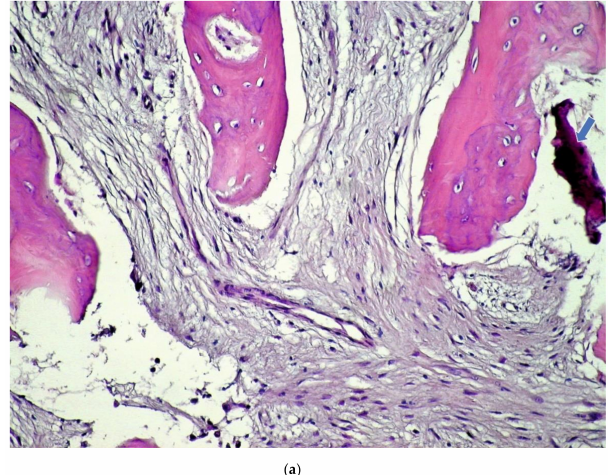
Figure 2. Panoramic radiograph showing the “onion-skin” appearance of the bone at full length of the mandible.